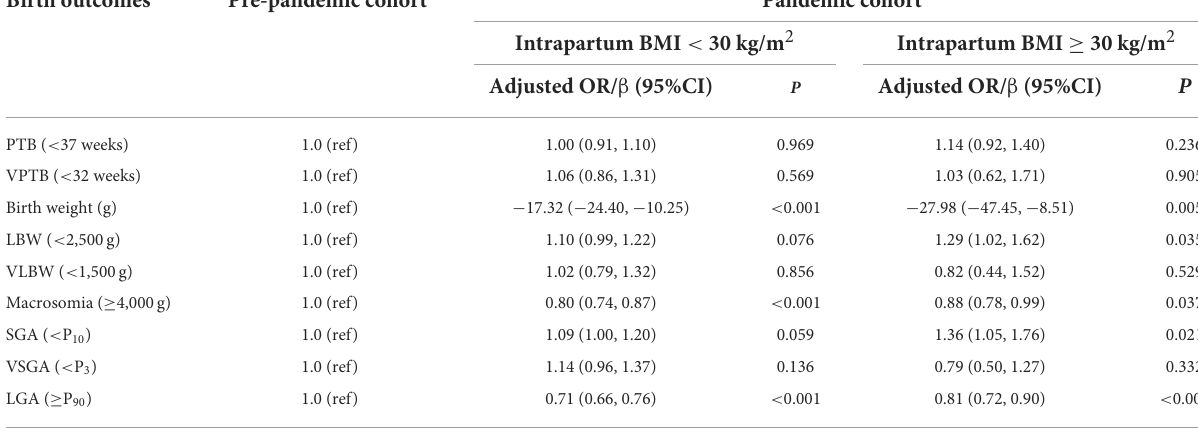
TABLE 4 Stratified analyses on the association between COVID-19 pandemic and birth outcomes by intrapartum BMI. Birth outcomes Pre-pandemic